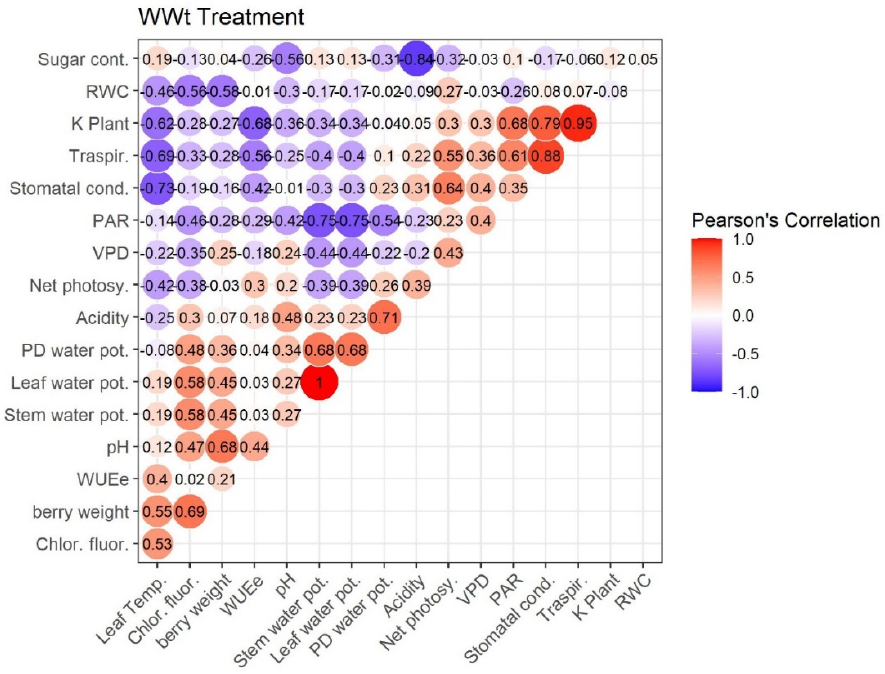
Figure 7. Pearson’s Correlation. WWt Treatment (Well-watered + Zeolite). Ecophysiological and technological correlations between the pairs of traits were analyzed. Correlations were calculated from the mean values of each of the four treatments characterized. Positive correlations are displayed in red and negative correlations in violet. The color intensity and the size of the circle are proportional to the correlation coefficients. The grey background boxes illustrate the significant values at the level of p < 0.05 (two-tailed).